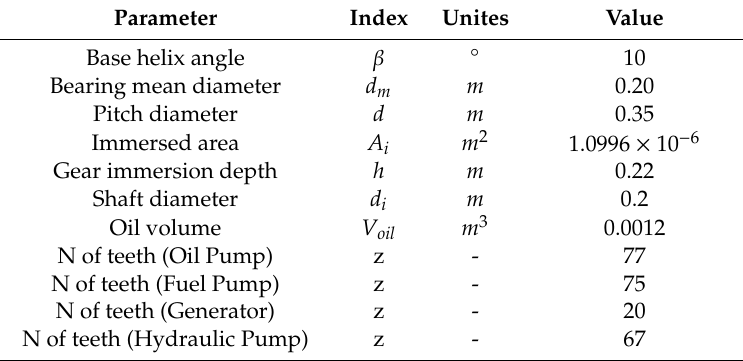
Table 3. Design parameters of AGB.